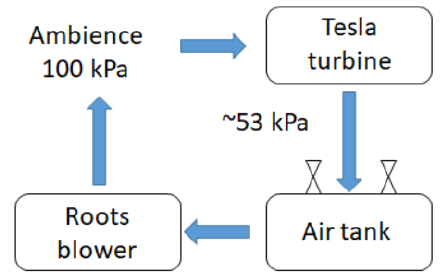
Figure 3. Scheme of air installation.